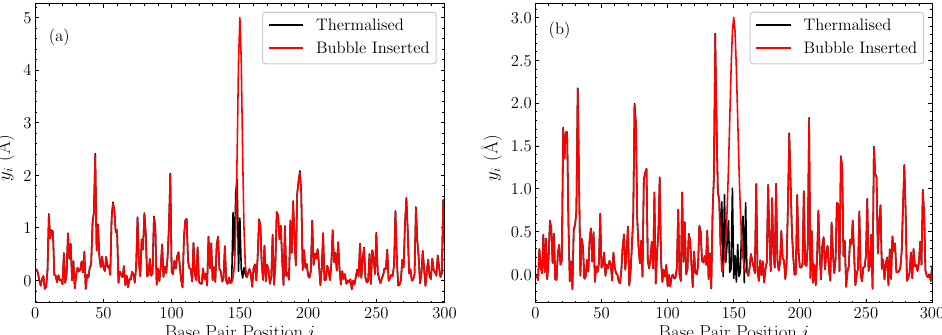
Figure 1. Two representative cases of the displacements in a thermalised homopolymer AT sequence at t = 10 ns (black), and the corresponding profile after the Gaussian perturbation is introduced and the remaining displacements rescaled (red). ( a ) bubble with a width w = 11 base pairs and amplitude h = 5 Å; ( b ) bubble with w = 19 base pairs and amplitude h = 3